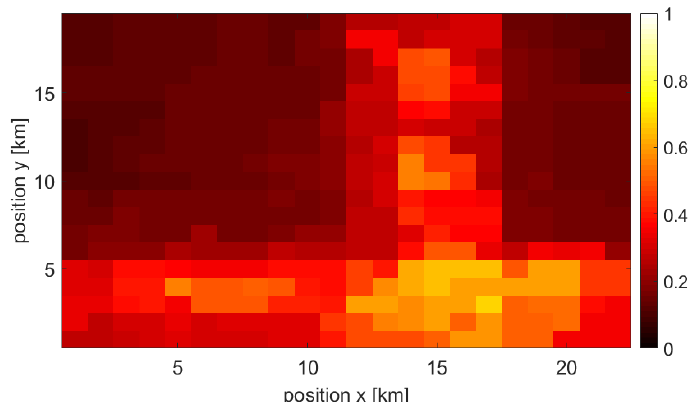
Figure 5. Example of a user density map merged using all three types of